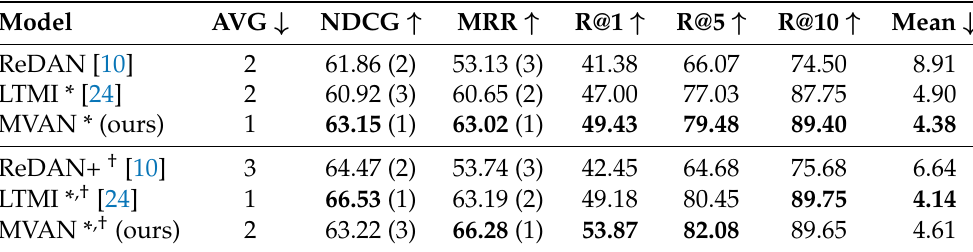
Table 2. Results of different methods of combining discriminative and generative models on VisDial v1.0 (test-std). † denotes ensembles and * indicates that the model was trained using multi-task learning. Model